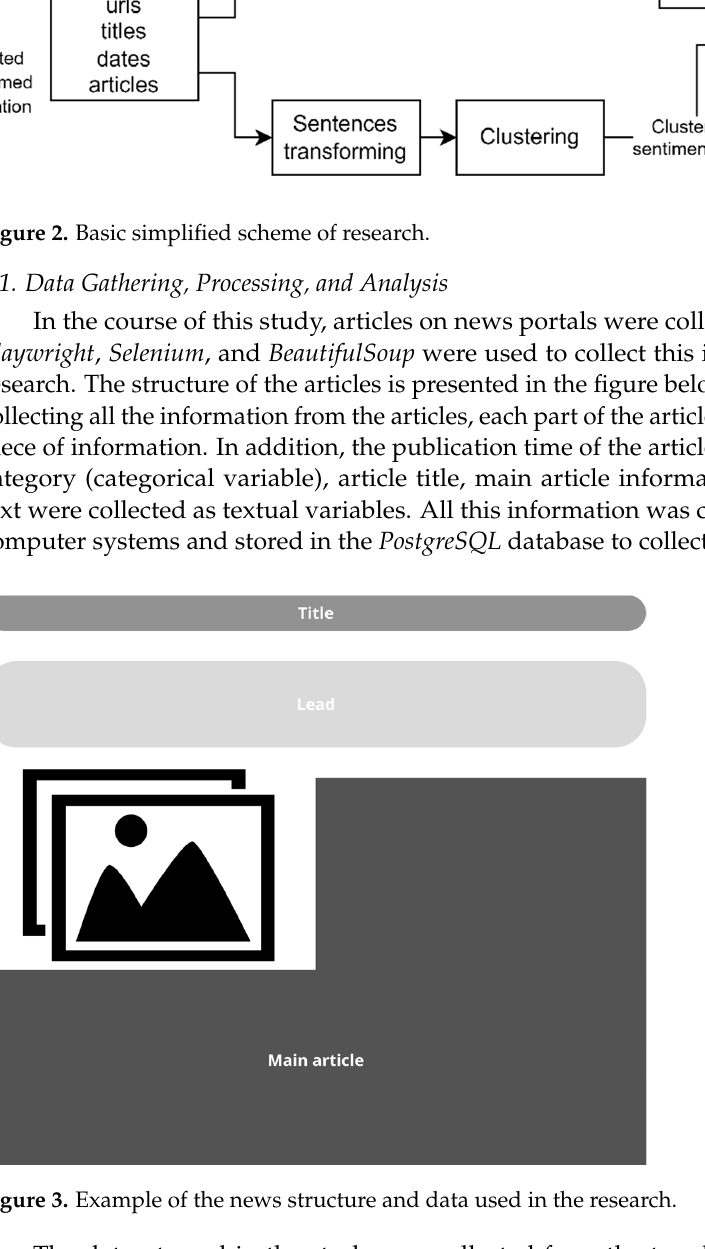
Figure 3. Example of the news structure and data used in the research.